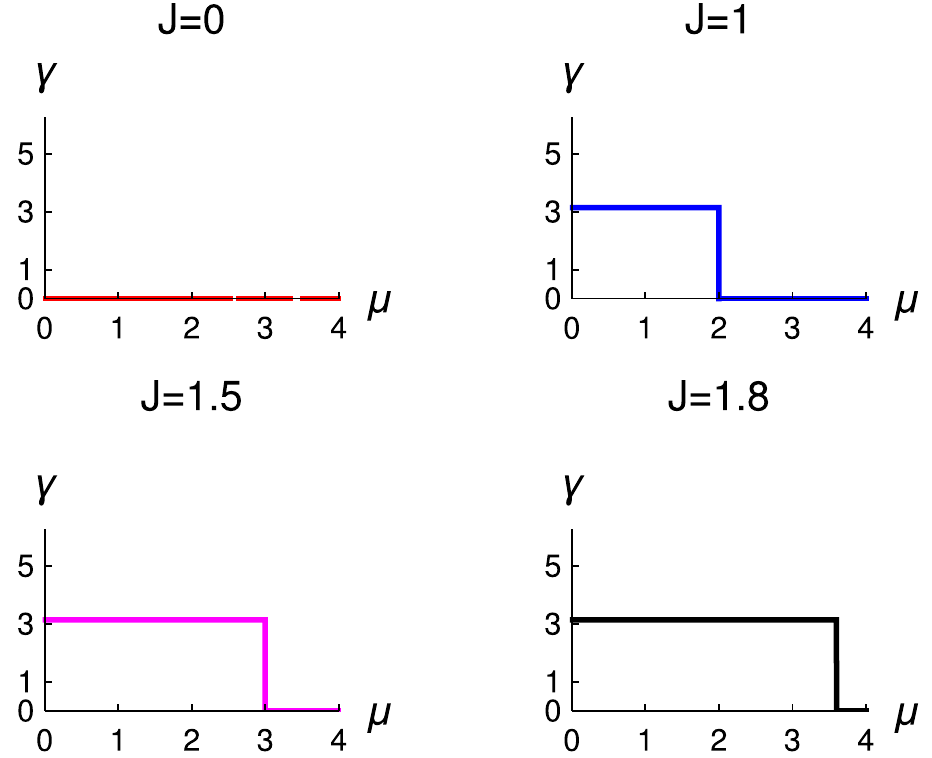
Figure 5. The variation of Zak phase ( γ ) with μ for different values of J . We study four values of J = 0.5, 1, 1.5, 1.8 for the colour red, blue, magenta and black respectively, Δ =